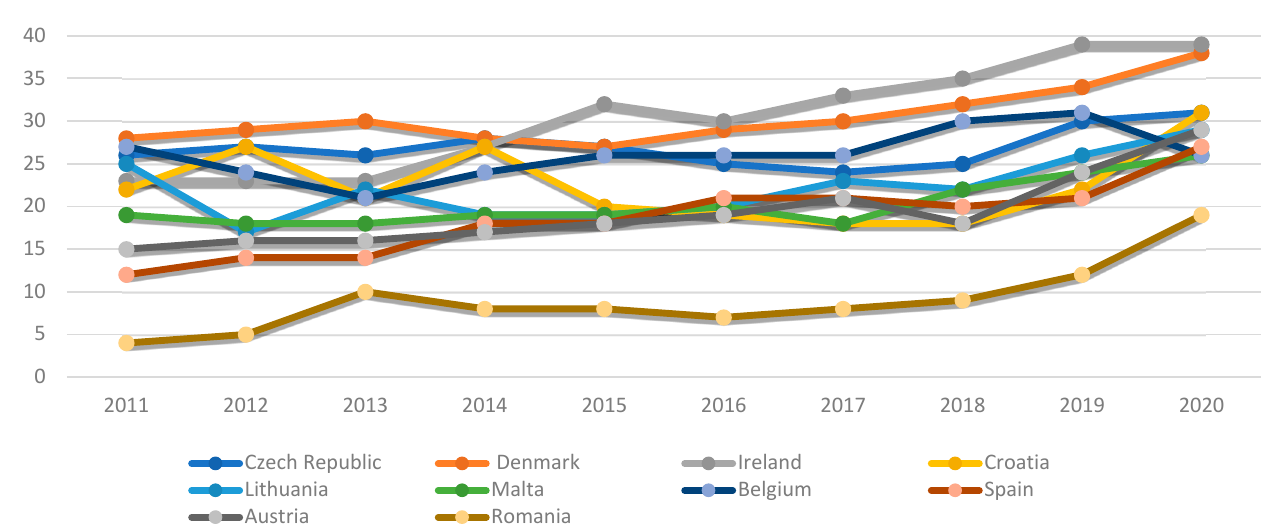
Figure 7. The evolution of B2B and B2G web sales companies.